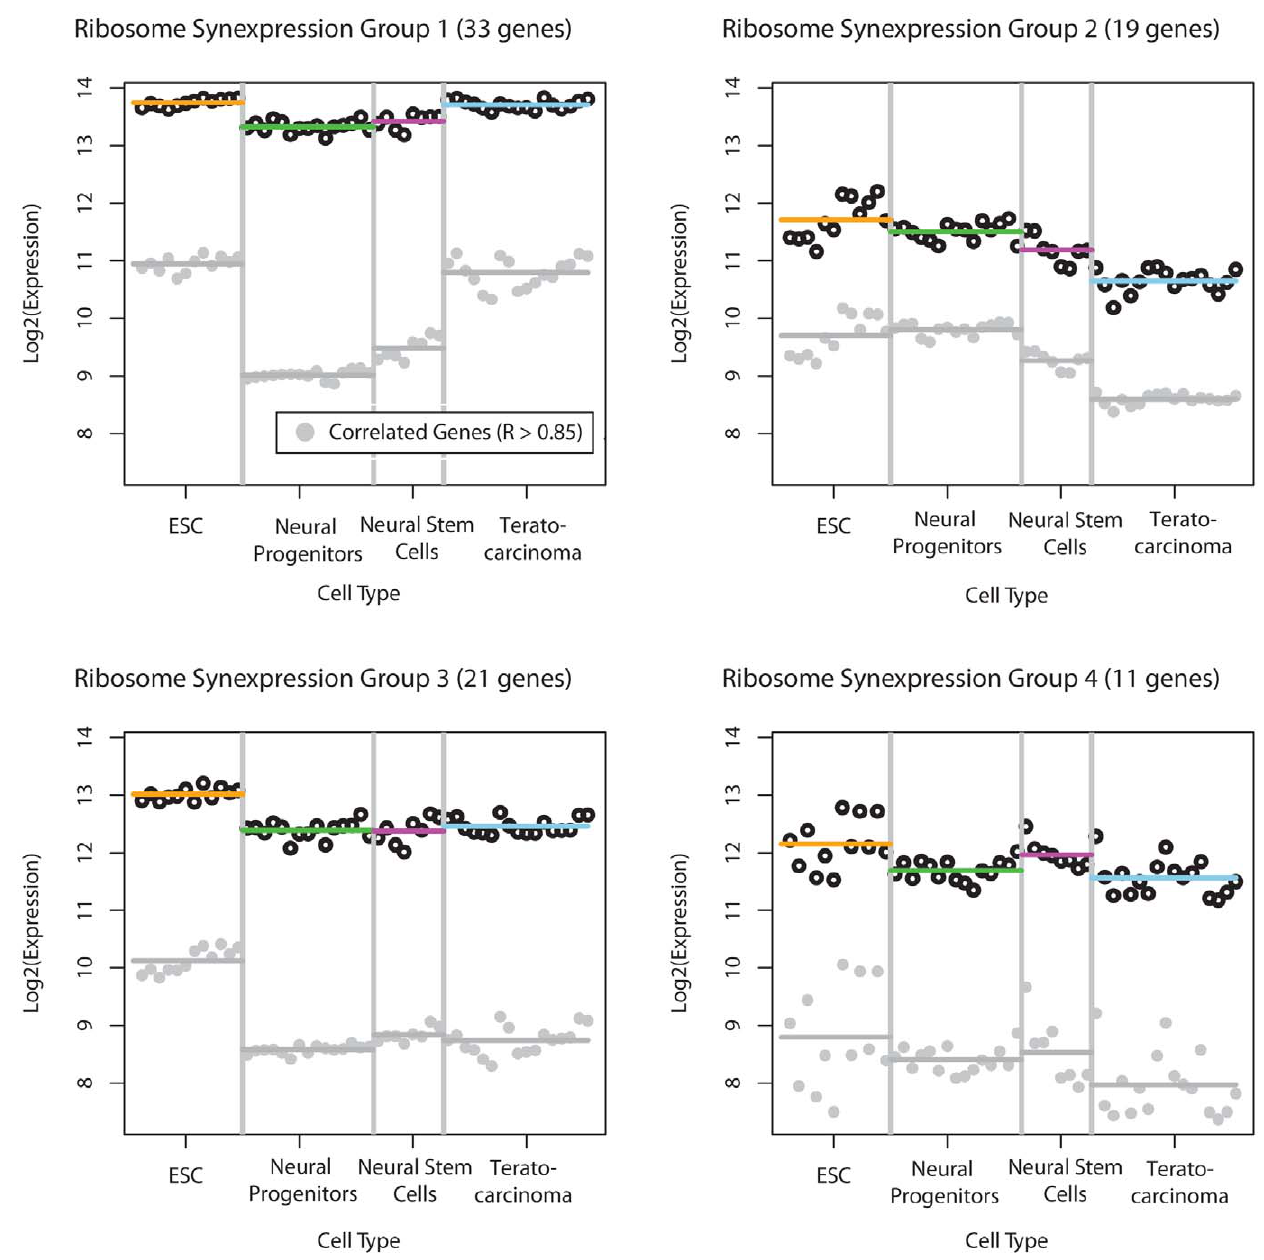
Figure 3. Synexpression groups and their correlated sets for the Ribosome pathway. Log (2) Expression on the x-axis and sample categories are listed across the Y-axis. Each black circle represents the average gene expression for each sample within a group, and corresponding colored bar the average expression for that cell type; Similarly, each grey circle represents the average correlated gene expression for each sample and grey bar the average expression for that cell type.